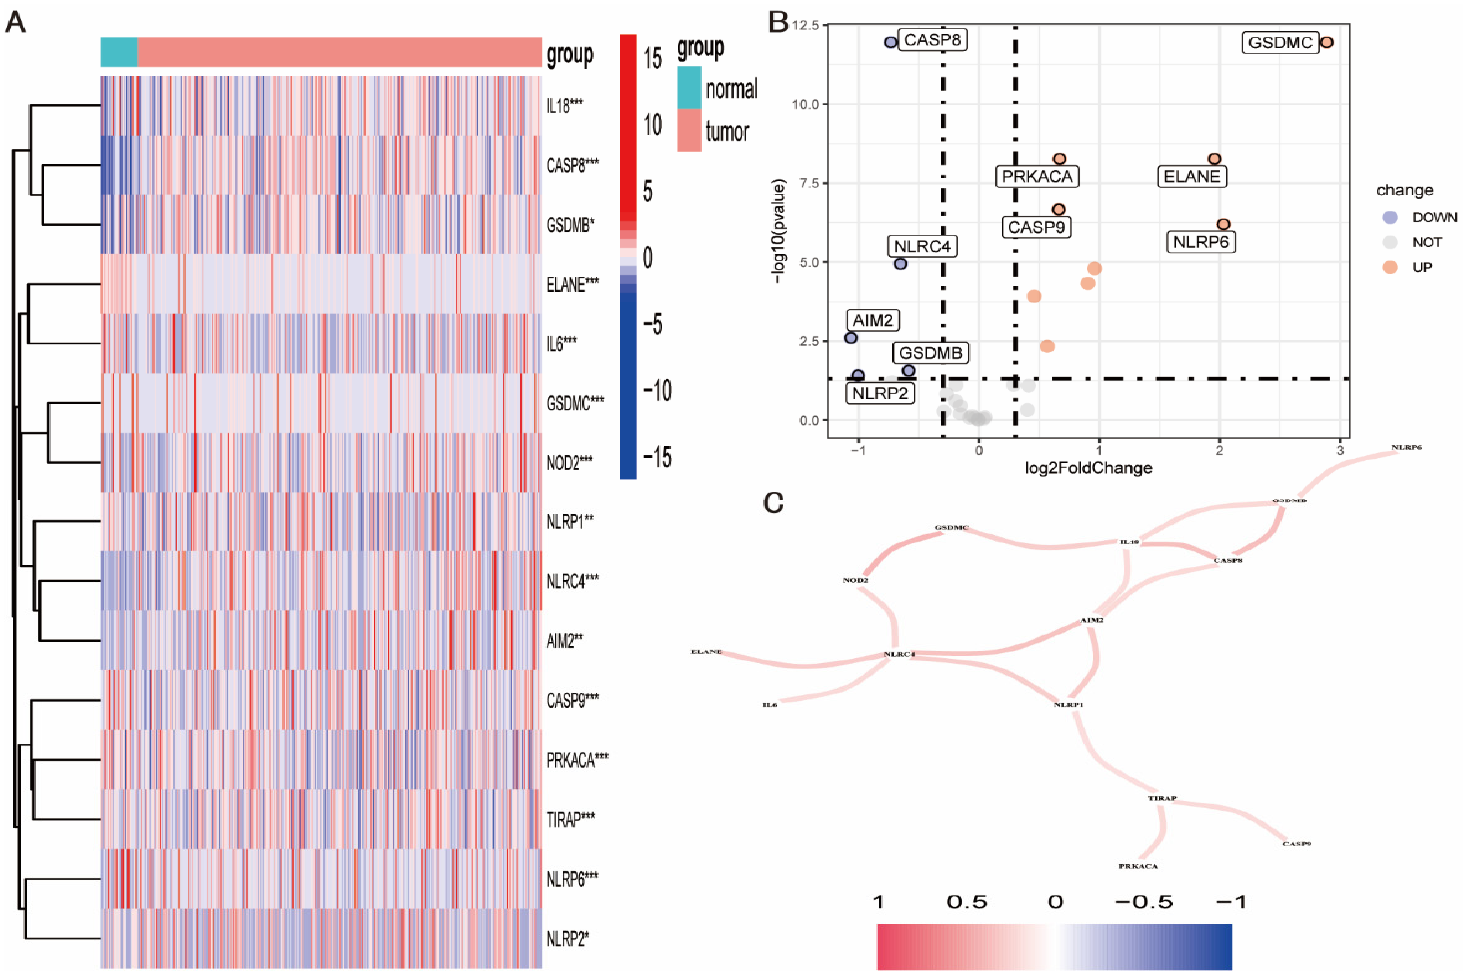
Figure 1. Screening pyroptosis-related DEGs in GC. ( A ) Heat map of pyroptosis-related differentially expressed genes between GC and para-cancer tissues. * 0.05; ** 0.01; *** 0.001. ( B ) Volcano map of pyroptosis-related differentially expressed genes between GC and para-cancer tissues. ( C ) Gene interaction analysis was conducted on pyroptosis-related differentially expressed genes with absolute correlation value > 0.2.